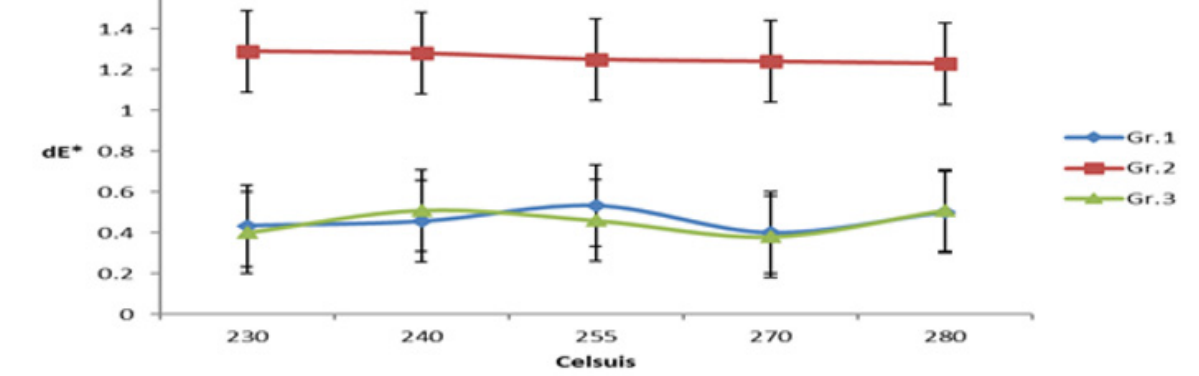
Figure 2. Temperature effects on dE* for Grade 1, Grade 2 and Grade 3.